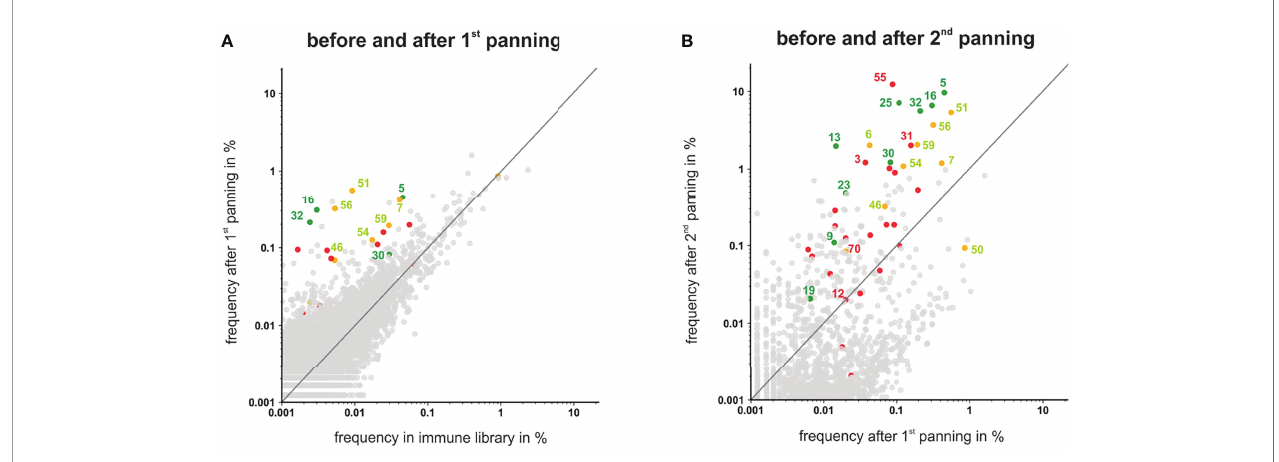
FIGURE 4 | Scatter plots showing the frequencies of VH clonotypes after fi rst and second panning. After the fi rst (A) and second (B) panning VHs were sequenced by NGS, analyzed by ARResT/Interrogate and plotted. VH clones corresponding to scFv phages that showed binding to L-363 and only low or moderate binding to PBMC are labeled green. VH clones corresponding to scFv phages that bound to L-363, but were excluded due to PBMC binding, are labeled yellow. Candidates that showed no/low binding on L-363 are labeled red. Binding properties of the grey clones were not tested yet. VH clones depicted above the grey lines have a higher frequency in the library after panning than